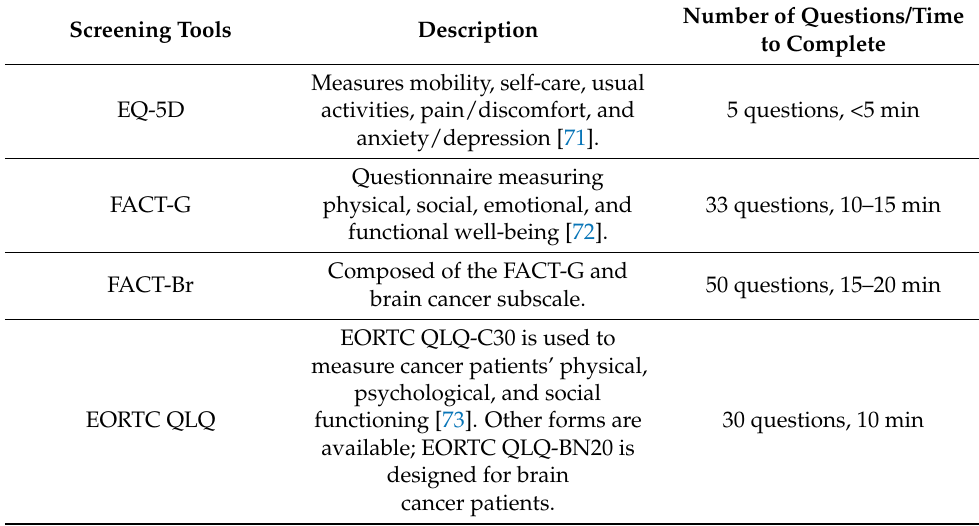
Table 1. Tools for measuring QOL in BM